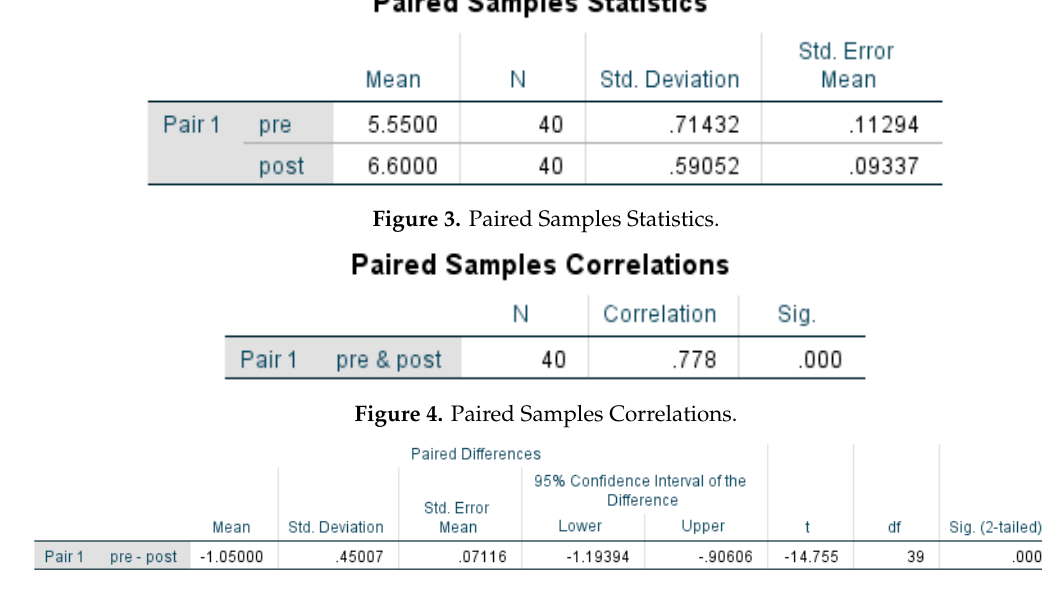
Figure 5. Paired Samples Test.